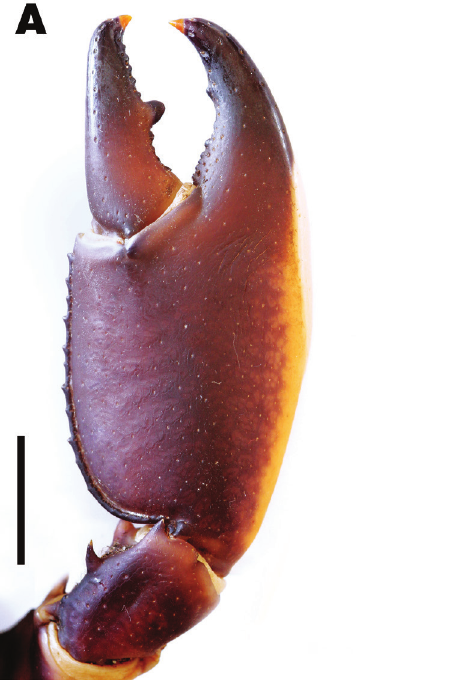
Figure 5. Cherax warsamsonicus sp. n. holotype male (MZB Cru 4529). A right first chela, dorsal aspect B right first chela, ventral aspect. Scale bars: 10